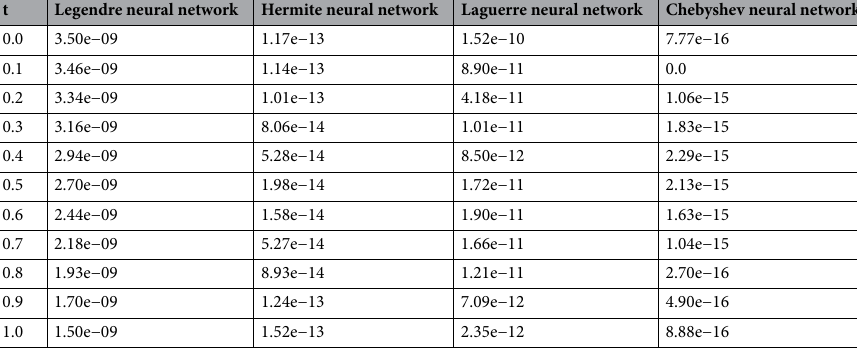
Table 5. The relative error for Example−6.3 with different orthogonal neural networks.